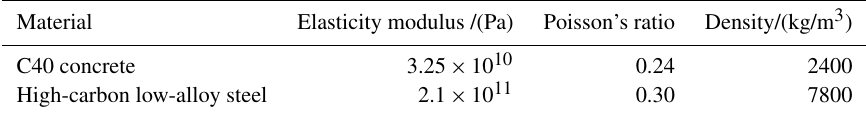
Figure 2. Friction self-excited vibration model of the wheel–rail system. (a) Wheel–rail system model. (b) Lateral contact geometry rela- tionship between the outer wheel and outer rail (including the slab). (c) Lateral contact geometry relationship between the inner wheel and inner rail (including the slab). (d) Longitudinal contact geometry relationship between rail and slab. Table 2. Material properties of each component.